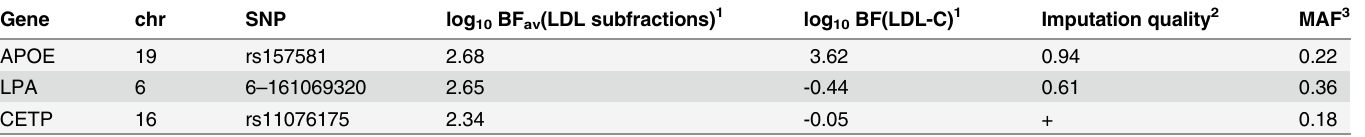
Table 3. Summary of the secondary associations with LDL subfractions in our analysis.